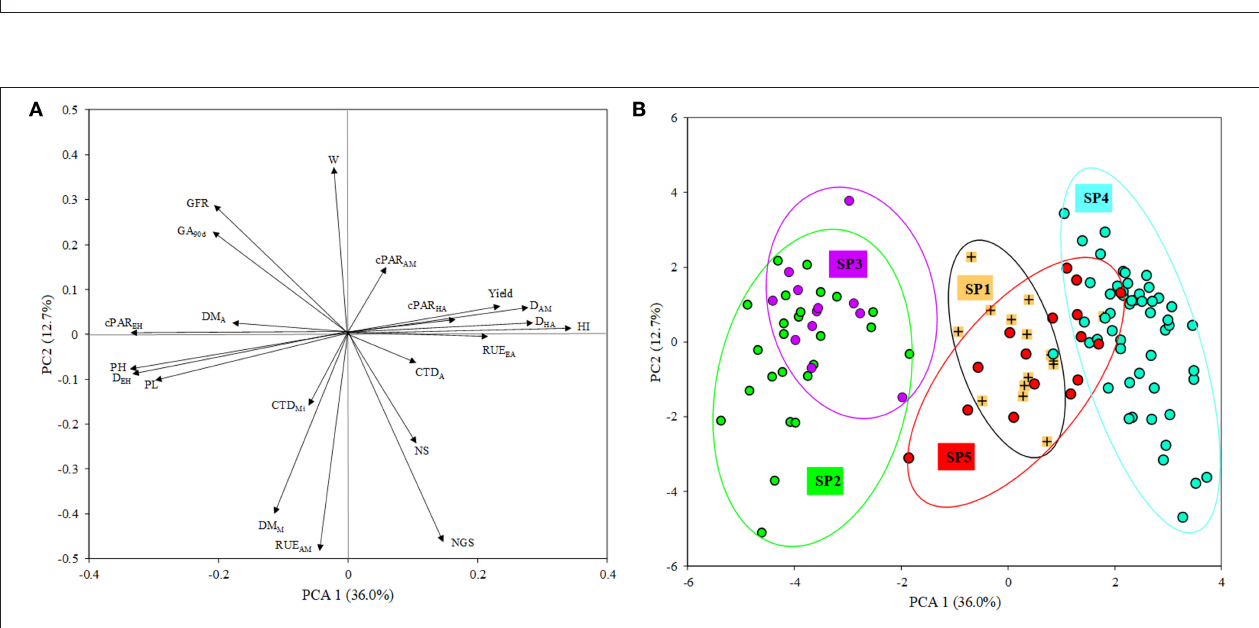
FIGURE 3 | Biplot of principal component analysis (PCA). (A) Eigenvalues of the correlation matrix symbolized as vector representing the traits measured in the study. NS, number of spikes/m 2 ; NGS, number of grains/spike; W, grain weight; HI, harvest index; DEH, days from emergence to heading; DHA, days from heading to anthesis; DAM, days from anthesis to maturity; GFR, grain filling rate; PL, peduncle length; PH, plant height; DM A , dry matter at anthesis; DM M , dry matter at maturity; CTD A , canopy temperature depression at anthesis; CTD Mi , canopy temperature depression at milky-dough grain stage; RAD EH , absorbed radiation from emergence to heading; RAD HA , absorbed radiation from heading to anthesis; RAD AM , absorbed radiation from anthesis to maturity; RUE EA , radiation use efficiency from emergence to anthesis; RUE AM , radiation use efficiency from anthesis to maturity; GA 90d , green area accumulated at 90 days from emergence. (B) Points representing durum wheat landraces and modern cultivars with a membership coefficient q > 0.80 to five genetic subpopulations (SP).